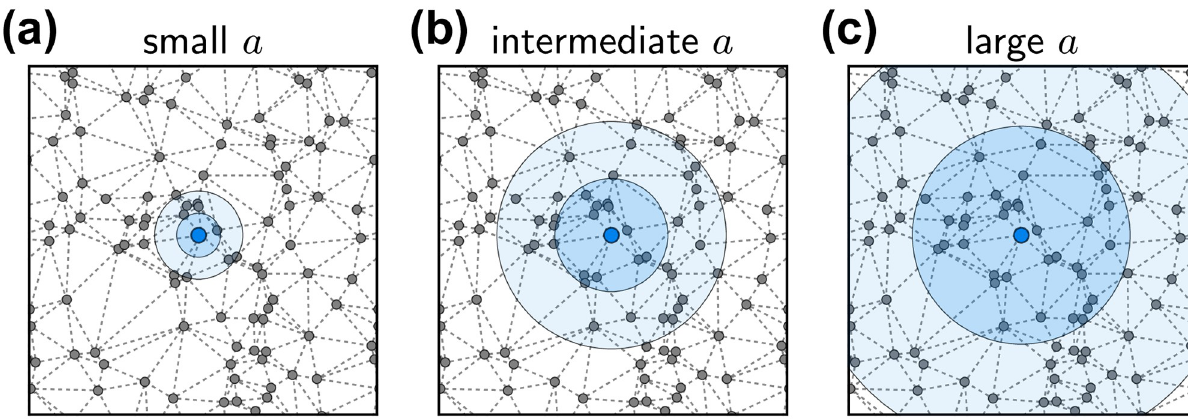
Fig 5. Impact of a single customer. Sketch of the effect of a single (new) customer for a node. With the new customer production increases and the production costs per unit decrease by aD (economies of scale). This compensates larger transport costs for nodes further away from the supplier. Consequently, the supplier becomes competitive in a larger range and can potentially attract additional customers. The blue disks indicate the distance that is compensated by the decrease in production costs due to one customer (two customers). (a) For small a , the change in production cost is small and likely has no immediate effect [compare a = 10 − 4 in Fig 4(a)]. The nodes have to compete at all length scales. (b) For intermediate a , a single customer may reduce the costs sufficiently to cause additional nodes to change their supplier. In this case, nodes have to compete at a local scale until they reach a size sufficiently large to take over the global cluster. (c) For large a , a single customer definitely reduces the costs sufficiently to cause a cascade of purchasing decisions and the first node to attract a customer takes over the whole cluster. Here, only the immediate neighborhood of a node decides about its success [compare a = 1 in Fig